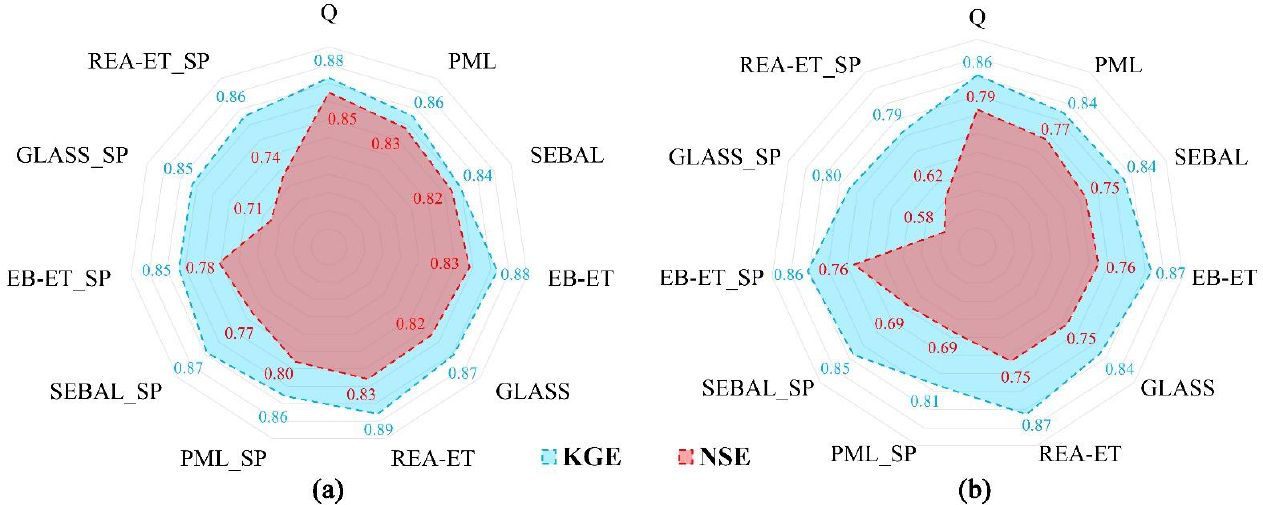
Figure 6. The performance of two calibration schemes with ET datasets (Schemes 2 and 3) on temporal dynamics of the streamflow at the outlet in the ( a ) calibration period and ( b ) evaluation period as compared to the benchmark calibration scheme (Scheme 1 is called “Q” for short here). The five ET datasets used in Scheme 2 are listed by names, and ET datasets used in Scheme 3 are listed and followed by “SP”.